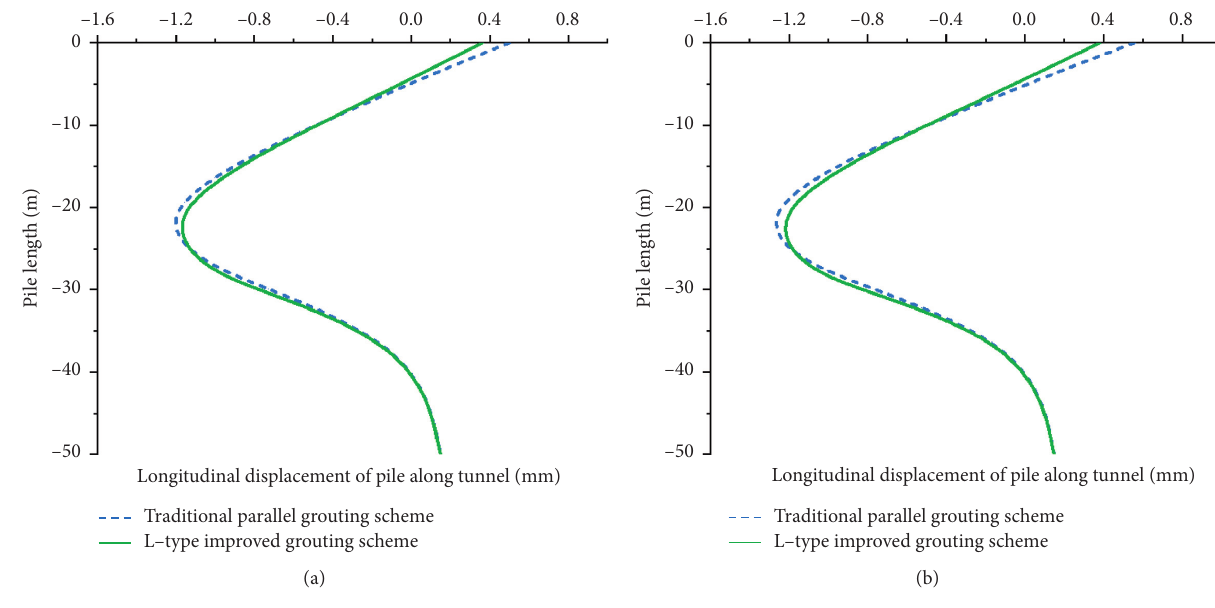
Figure 22: Longitudinal displacement of the pile along tunnel: (a) 2 rings before arriving at the pile; (b) arriving at the